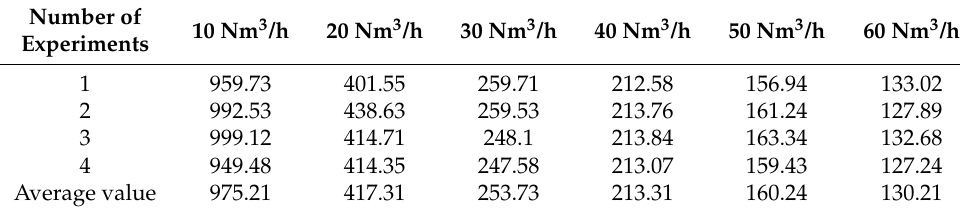
Table 12. Liquid content in Case 3 at M 1 (g/m 3 ).